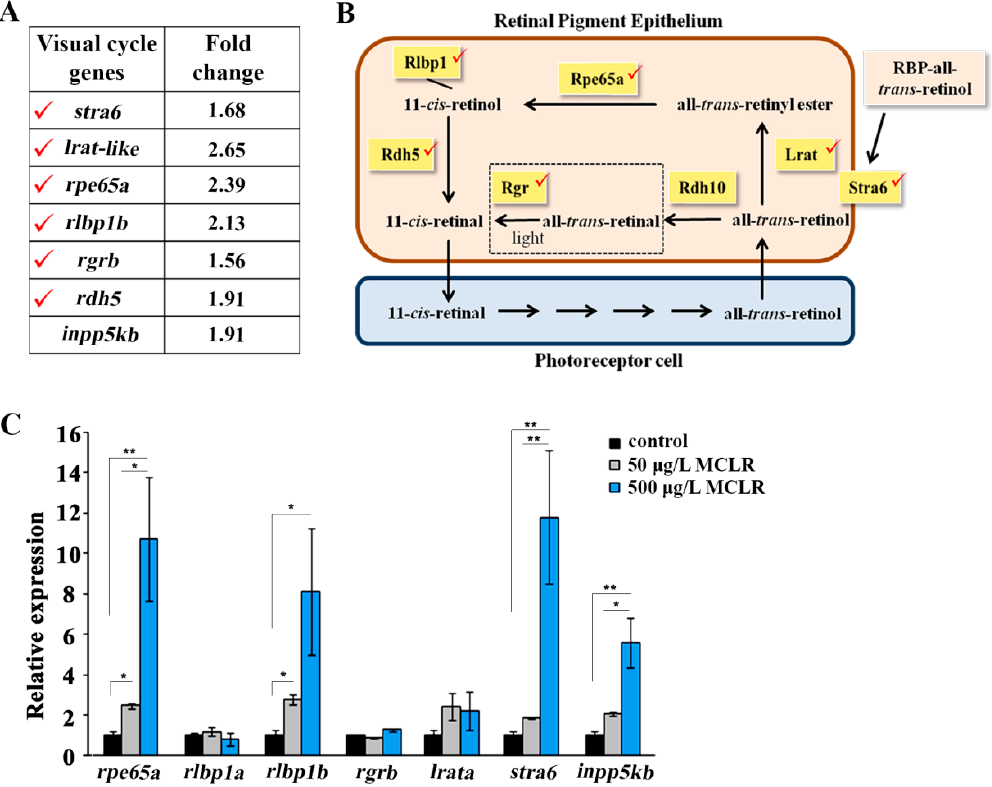
Figure 2. Gene expression profiling of MCLR exposed larvae ( A ) microarray analysis. Differentially expressed genes in zebrafish larvae treated with 500 μ g/L of MCLR involved in the retinoid visual cycle, p < 0.05. ( B ) The retinoid visual cycle. Briefly, absorption of light by visual pigments causes isomerization of 11- cis -retinal to all- trans -retinal, resulting in phototransduction. All- trans -retinal is reduced to all- trans -retinol and transported into the retinal pigment epithelium (RPE). LRAT esterifies all- trans -retinol to all- trans -retinyl esters, which are further processed to 11- cis -retinol by RPE65. RLBP1 removes 11- cis -retinol from the reaction site to speed the isomerization. RDH5 converts 11- cis -retinol to 11- cis -retinal. STRA6 receptor mediates all- trans -retinol uptake through the plasma membrane. Red check marks indicate the visual cycle-related genes detected in MCLR-treated larvae by microarray analysis. ( C ) Validation of microarray data by quantitative real-time PCR (qPCR) analysis. Relative mRNA expression of rpe65a, rlbp1a, rlbp1b, rgrb, lrata, stra6, and inpp5kb (inositol polyphosphate-5-phosphatase Kb) at a four-day exposure of larvae to 50 µ g/L and 500 µ g/L of MCLR. Three biological replicates were run in triplicate. The mRNA expression levels are expressed in relation to the control which is set to 1. * p < 0.05 and ** p < 0.01. RBP: Retinol binding protein.